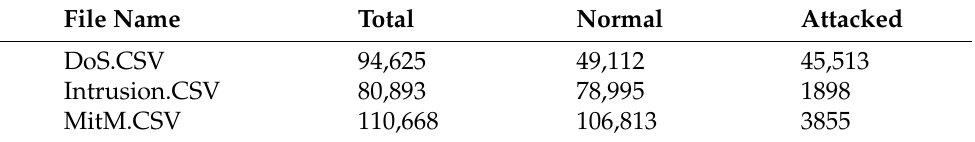
Table 5. MQTT dataset 1